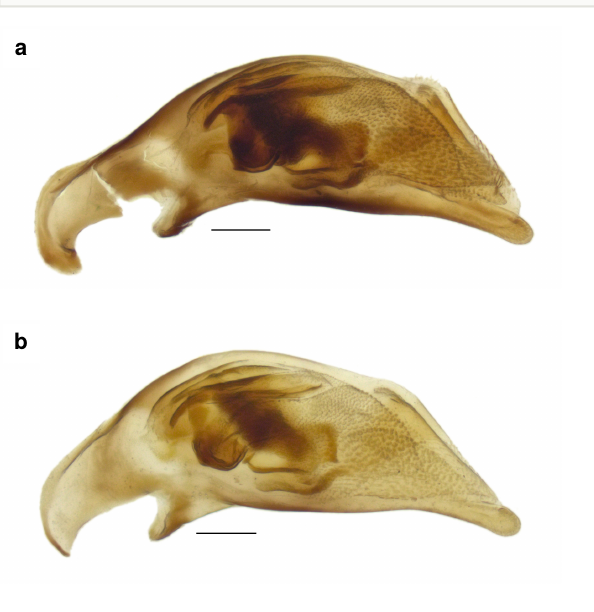
Figure 4. Male aedeagi of Bembidion ambiguum . Scale bars are 0.1